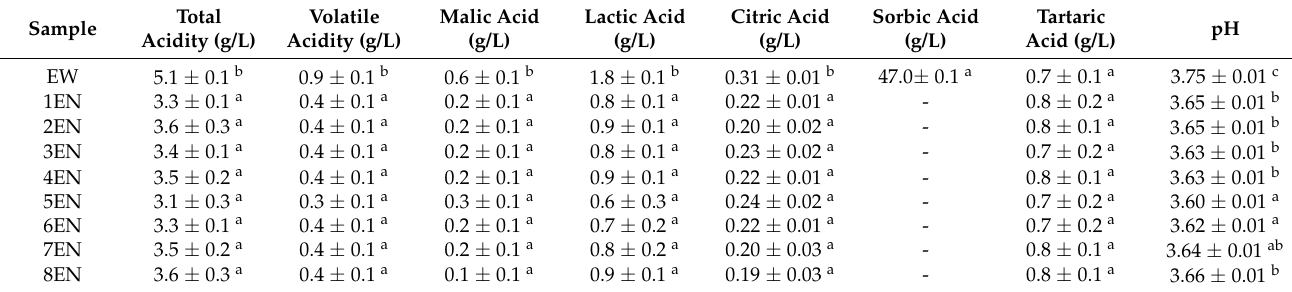
Table 8. Total acidity, volatile acidity, malic, lactic, citric, sorbic and tartaric acid and pH in initial ecological